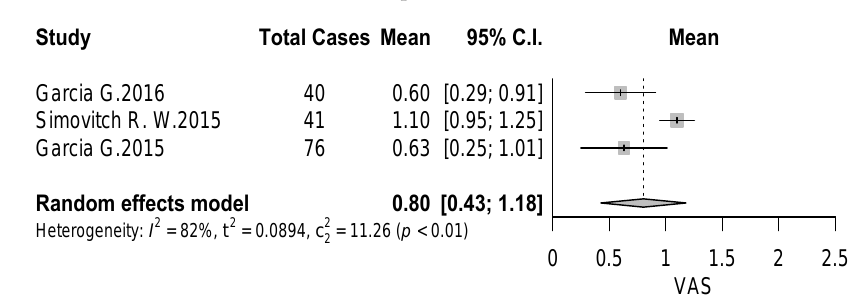
Figure 9. Forest plot chart of ASES score.